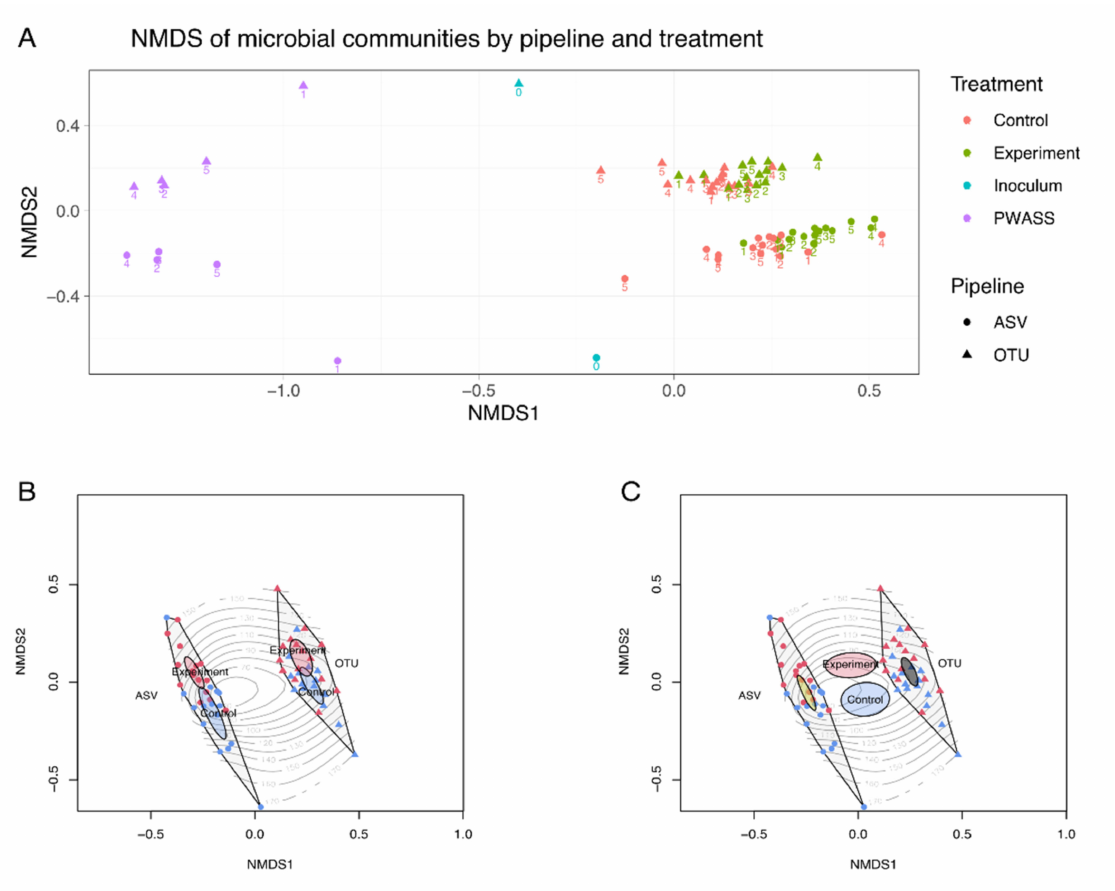
Figure 4. Nonmetric multidimensional scaling plot of the microbial populations identified by the two pipelines. ( A ) Shown is the full set of samples including PWASS, inoculum and control, and experimental reactor samples for both pipelines. Treatment levels, i.e., sample origin, is depicted by colors, with numbers representing the sampling time-point between 1 and 5 (0 for inoculum). The two pipelines are represented by different shapes. ( B ) and ( C ) Nonmetric multidimensional scaling ordination of the experimental and control thermophilic anaerobic digestion reactors only. Shape represents the pipeline, with triangles representing the OTU and circles representing the ASV pipeline. Added to the ordination is experimental runtime as contour lines, and pipelines are additionally depicted by polygons encompassing all samples belonging to either one or the other pipeline. 95% confidence intervals are included in the ordination as ellipsoids ( red = experimental reactors, blue = control reactors); ( B ) 95% confidence intervals are calculated and plotted pipeline wise; ( C ) 95% confidence intervals are calculated for the whole set of samples, with addition of confidence intervals for the two pipelines in yellow (ASV) and grey